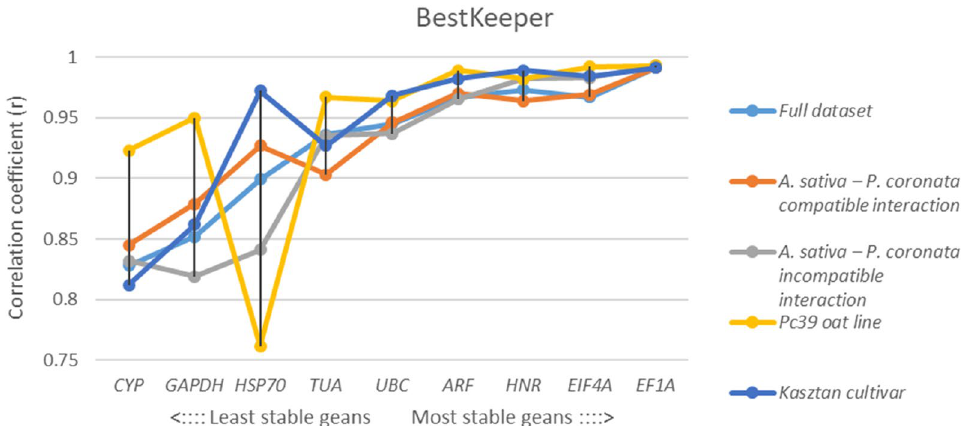
Figure 4. Correlation coefficients ( r ) of tested RGs determined by BestKeeper algorithm for full dataset, compatible interaction dataset, incompatible interaction dataset, Pc39 oat line dataset and Kasztan cultivar dataset. High coefficient of correlation indicates high expression stability across samples